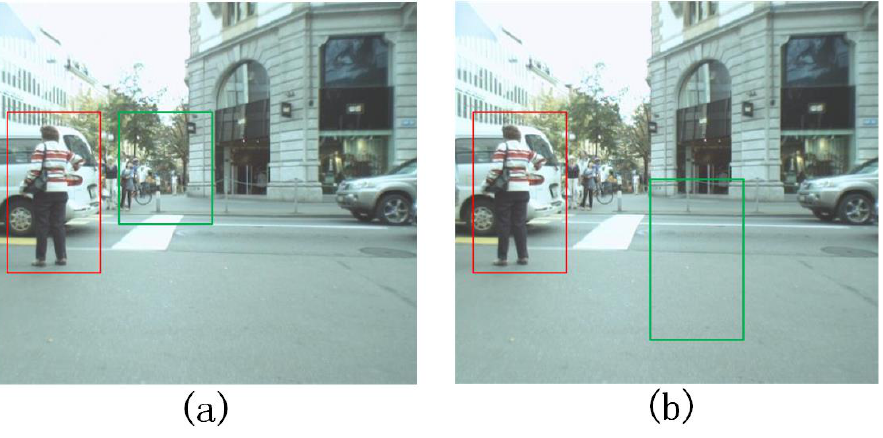
Figure 3. No coincident position relationship between detection frame and prediction frame. ( a ) The detection frame is close to the prediction frame. ( b ) The detection frame is far from the prediction